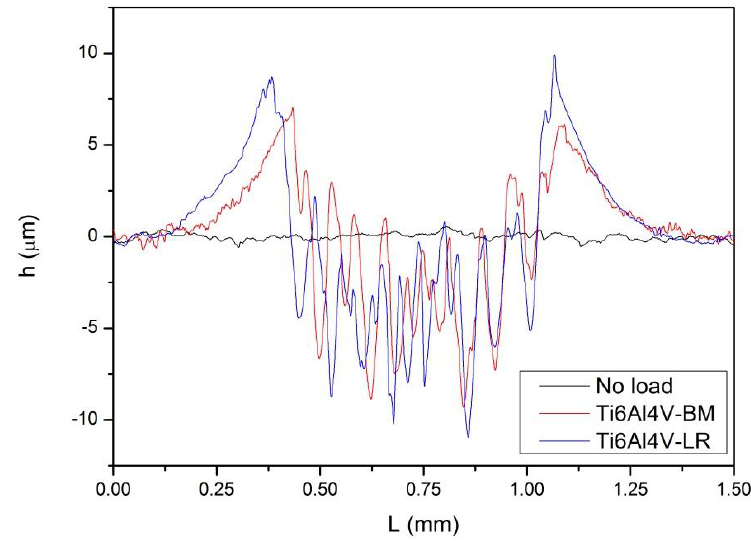
Figure 11. Profile of wear tracks obtained after the polarization curve tests.